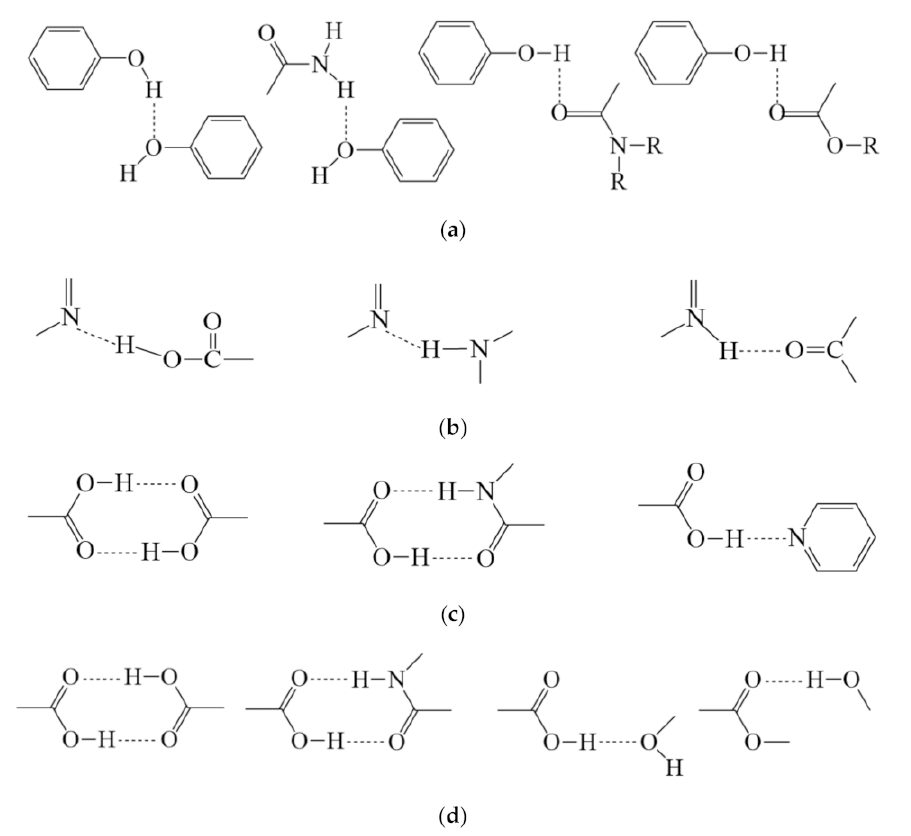
Figure 3. Typical hydrogen bounded elements in pharmaceutical cocrystals observed in ( a ) flavonoids, ( b ) alkaloids, ( c ) phenolic acids and ( d ) terpenoids.